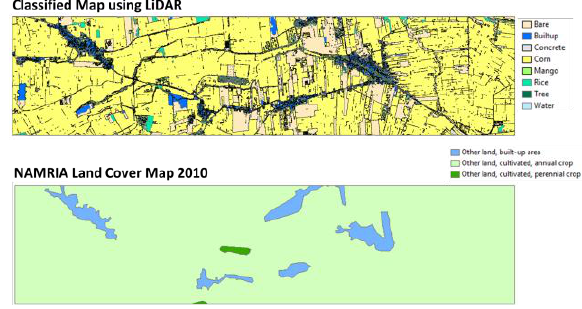
Figure 6. Detailed agricultural land cover (top image) and the corresponding portion taken from the NAMRIA land cover map dated 2010.